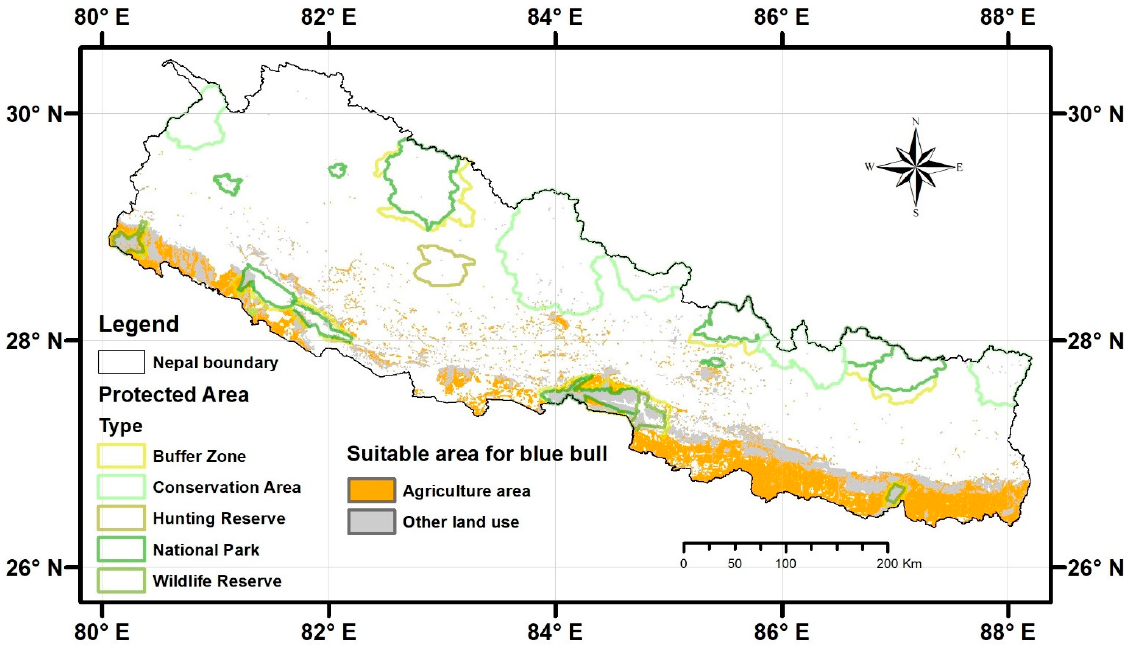
Figure 5. Map showing the overlap between suitable habitats of the Blue bull and different land use